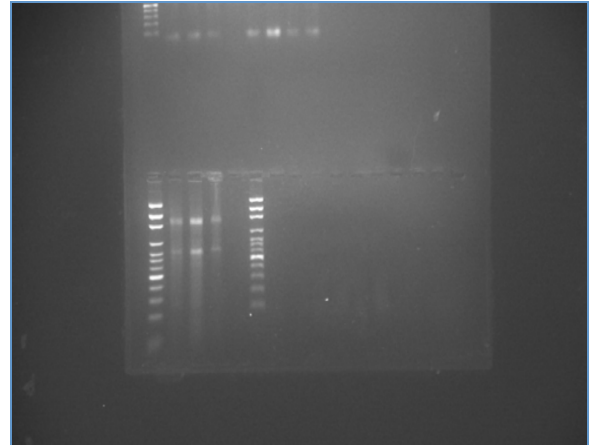
Figure 11. Picture of RNA sample using a garose gel electrophorsis and gel documentation